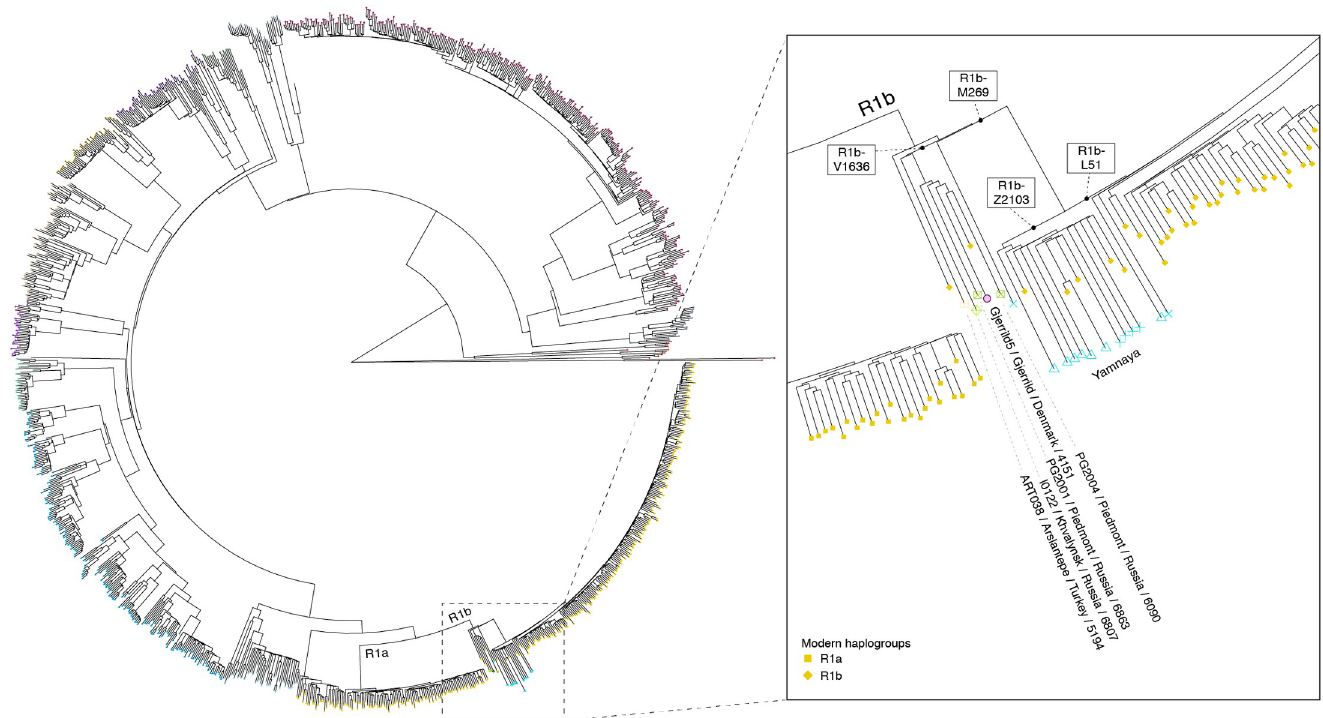
Fig 3. Phylogenetic placement of the Gjerrild 5 Y-chromosome haplogroup. Phylogenetic placement of Y chromosome sequences of Gjerrild 5 and selected ancient individuals with R1b haplogroups. Terminal branch lengths of ancient individuals in inset are not drawn to scale, to aid visualization of placements.